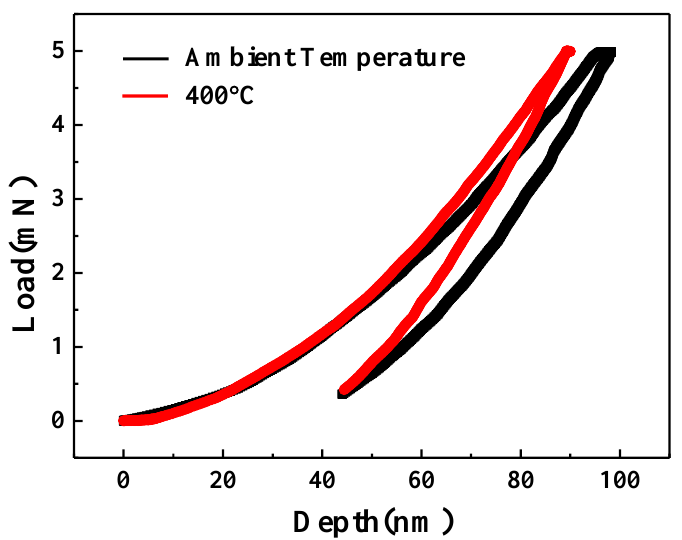
Figure 8. The typical load–displacement curves of Ta-Hf-C coatings under different deposition temperature.